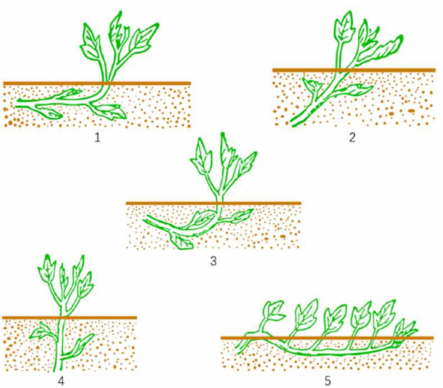
Figure 1. Schematic diagram of sweet potato planting method: 1. Horizontal method; 2. Oblique method; 3. Boat bottom planting; 4. Straight planting; 5. Pressing rattan